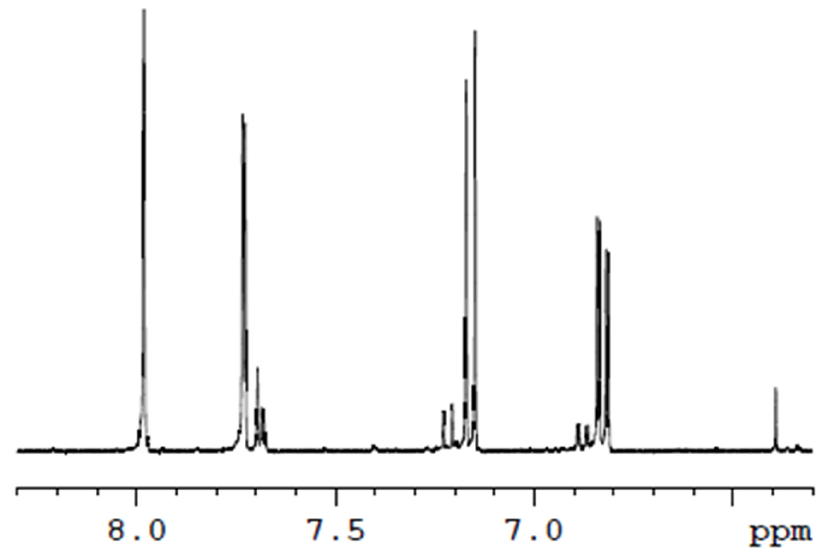
Figure 1. Zoom of the 1 H-NMR spectrum of 1 on the signals used to quantify the fraction of diketo tautomer.